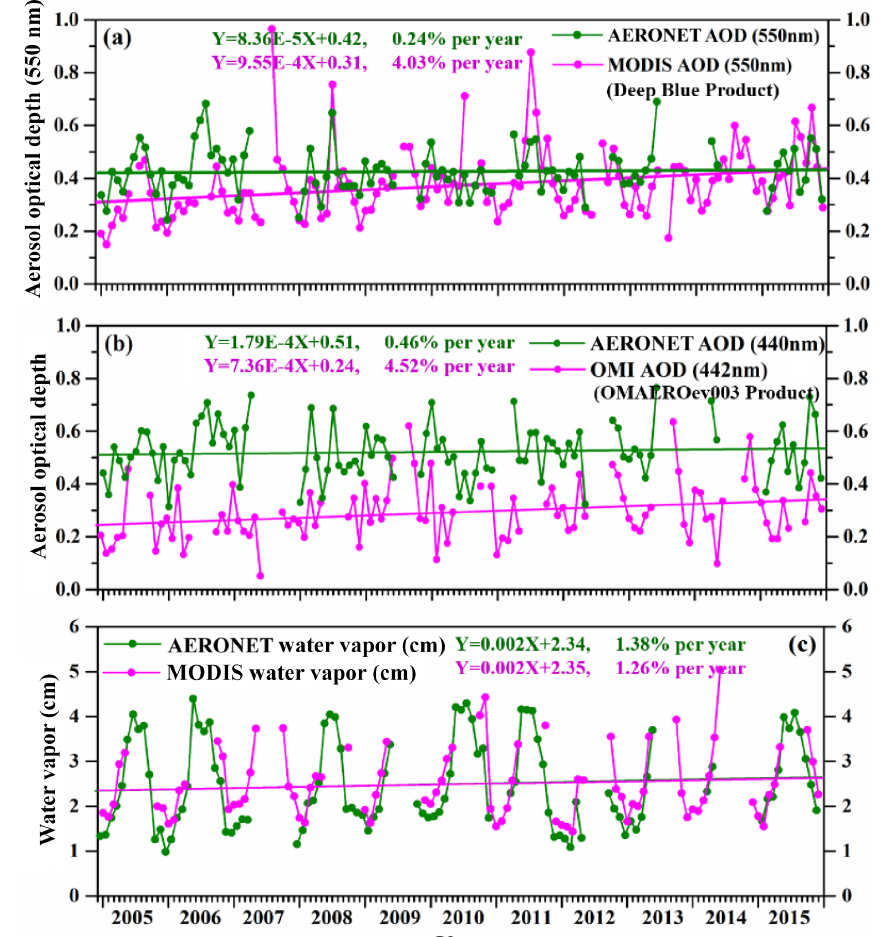
Figure 15. Long-term monthly mean variation of AOD and water vapor (cm) datasets from ground-based and satellite